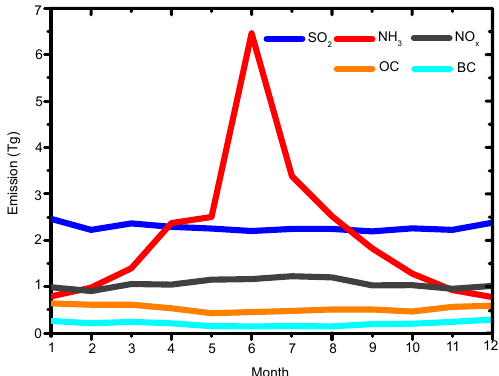
Figure 2. Monthly variations in emissions of NO x (TgNmonth − 1 ), SO 2 (TgSmonth − 1 ), NH 3 (TgNmonth − 1 ), OC (TgCmonth − 1 ), and BC (TgCmonth − 1 ) over Asia. Values shown are the total emis- sions (anthropogenic plus natural emissions listed in Table